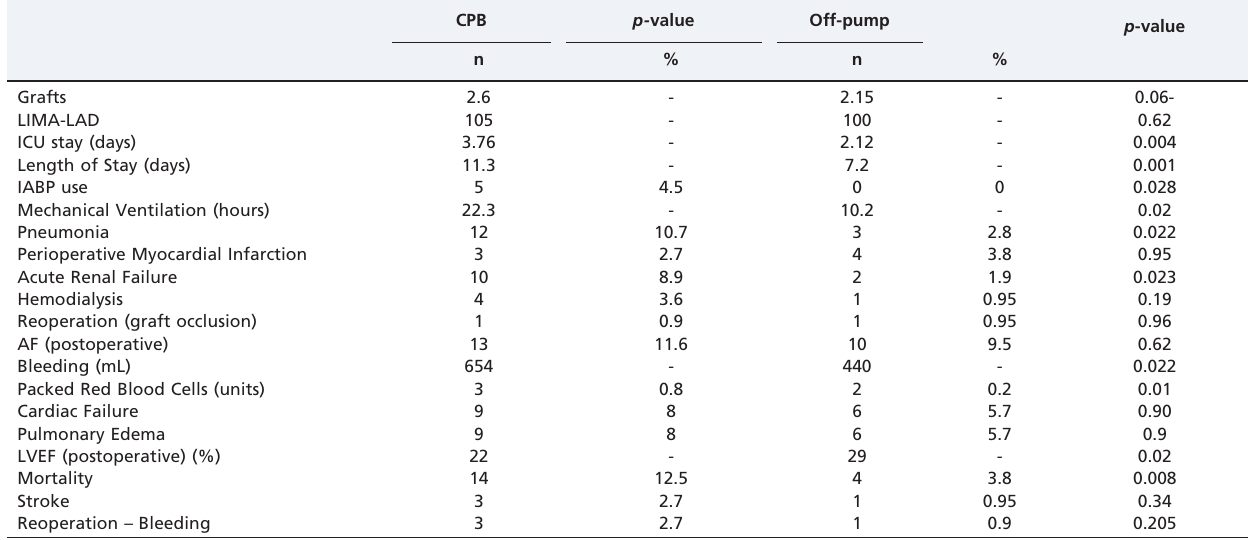
Table 2 - Postoperative